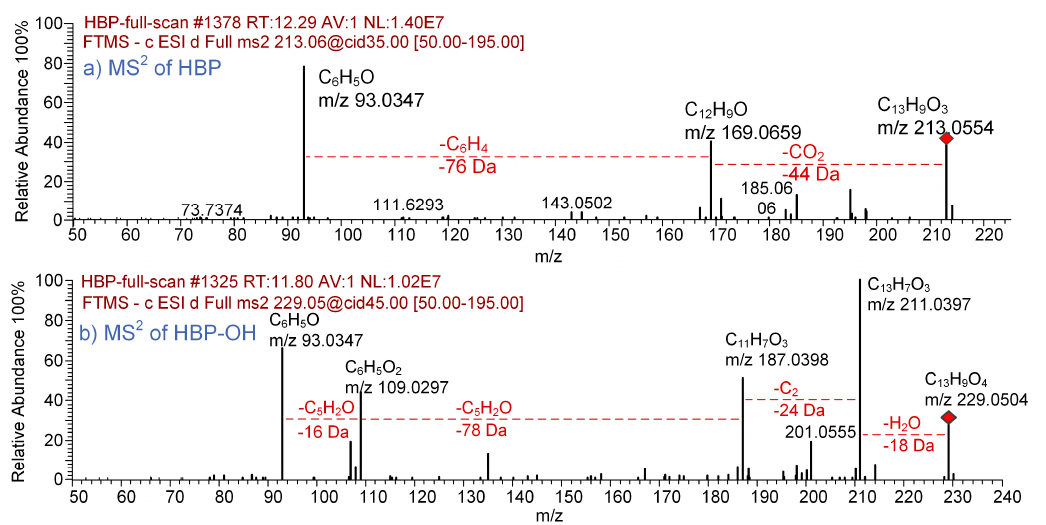
Figure 9. MS 2 spectra of HBP and its degradation product obtained by LTQ-Orbitrap, ( a ) HBP, ( b ) HBP-OH.